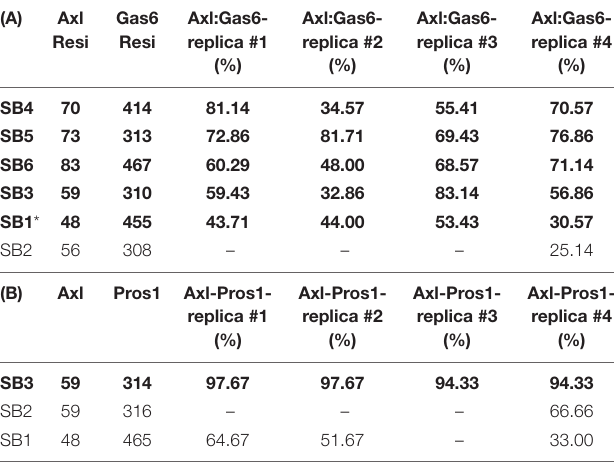
Each row indicates the observation frequency of the denoted salt bridge. The SB numbering follows the ones used in Figure 2C . The consistent and stable SBs are marked in bold. * corresponds to the SB1* presented in Figure 3B